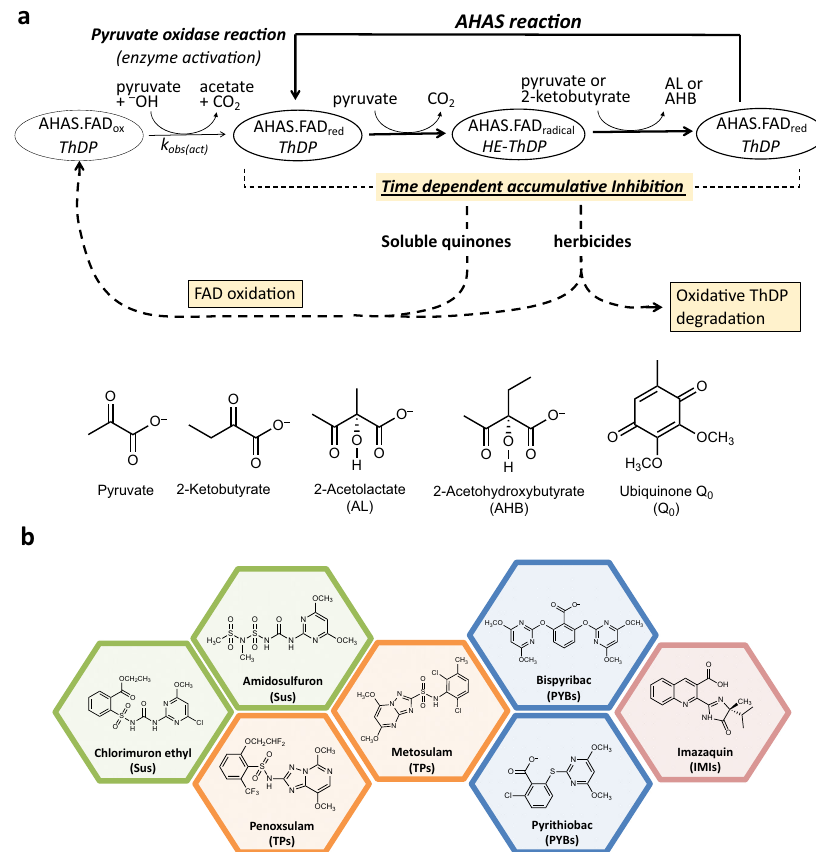
Fig. 2 Reaction pathways, substrates, products, and inhibitors associated with the AHAS-catalyzed reaction. a Scheme representing the catalytic reaction of AHAS and its inhibition by soluble quinones and herbicides. b Chemical structures of the seven herbicides from four different classes studied here. SUs (chlorimuron ethyl (CE) and amidosulfuron (AS)), TPS (metosulam (MT) and penoxsulam (PS)), PYBs (bispyribac (BS) and pyrithiobac (PB) and IMIs (imazaquin (IQ)). FAD ox = oxidized FAD. FAD red = FAD reduced. FAD rad = FAD semi-reduced. HE-ThDP = hydroxyethyl thiamine